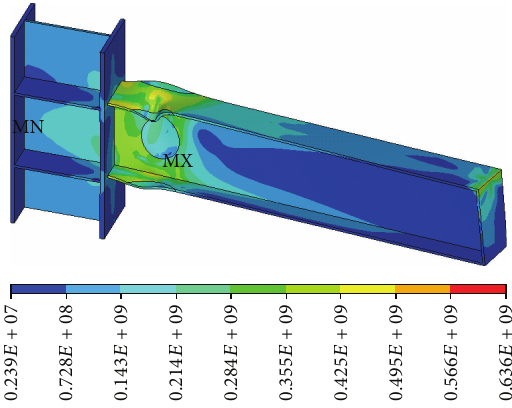
Figure 14: Stress of replaceable connection 1.